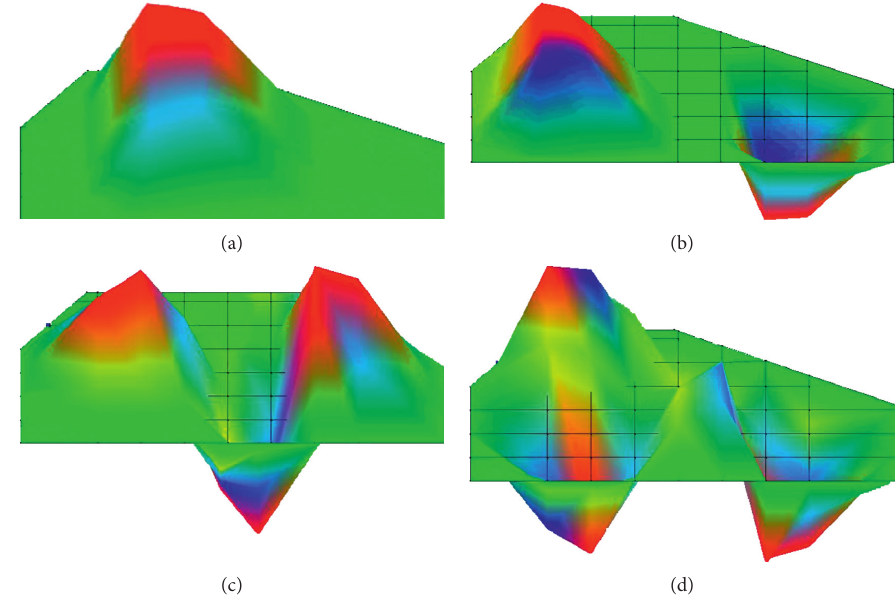
Figure 8: Measured mode shape of composite floor: (a) order 1; (b) order 2; (c) order 3; (d) order